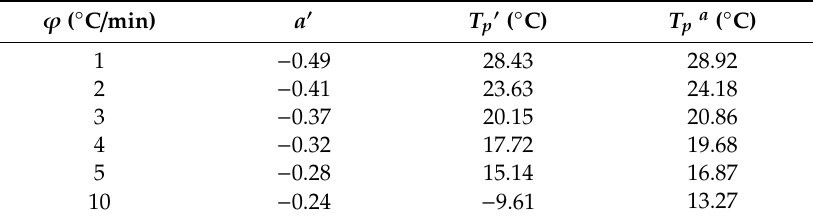
Figure 7. Plots of ln{ − ln[1 − χ ( T )]} against temperature for non-isothermal crystallization of P4HB with cooling rates as a parameter ( a ). Determination of the Avrami exponent using linear plots of T p ′ against (ln φ )/a ′ ( b ). Table 3. Characteristic crystallization parameters obtained for P4HB by using the methodology developed by Cazé et al. [30].